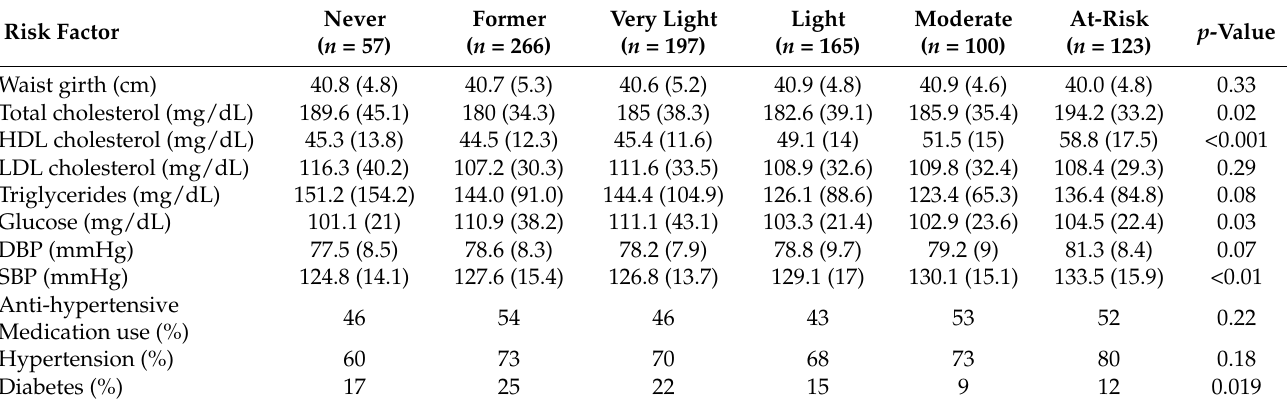
Table 3. CVD risk factors by drinking